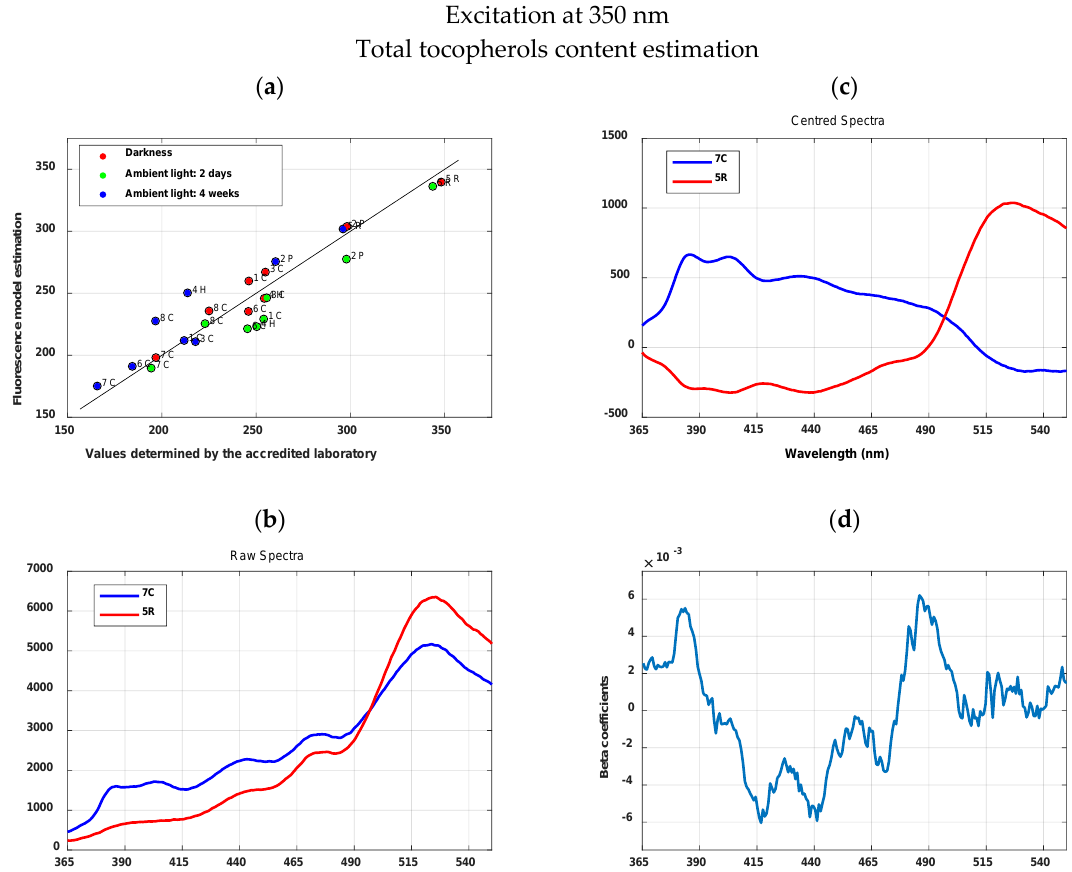
Figure 6. PLSR with 4 latent variables for estimation of total tocopherols content with excitation at 350 nm. ( a ) Total tocopherols values determined by the accredited laboratory versus the values estimated with the fluorescence models (colors refer to the three illumination conditions); ( b ) Spectra of 5R (red circle) and 7C (red circle) of high and low total tocopherols content respectively; ( c ) the two spectra centered with respect to the average of the whole sampling group ( N = 24); ( d ) beta coefficients of the estimation model.